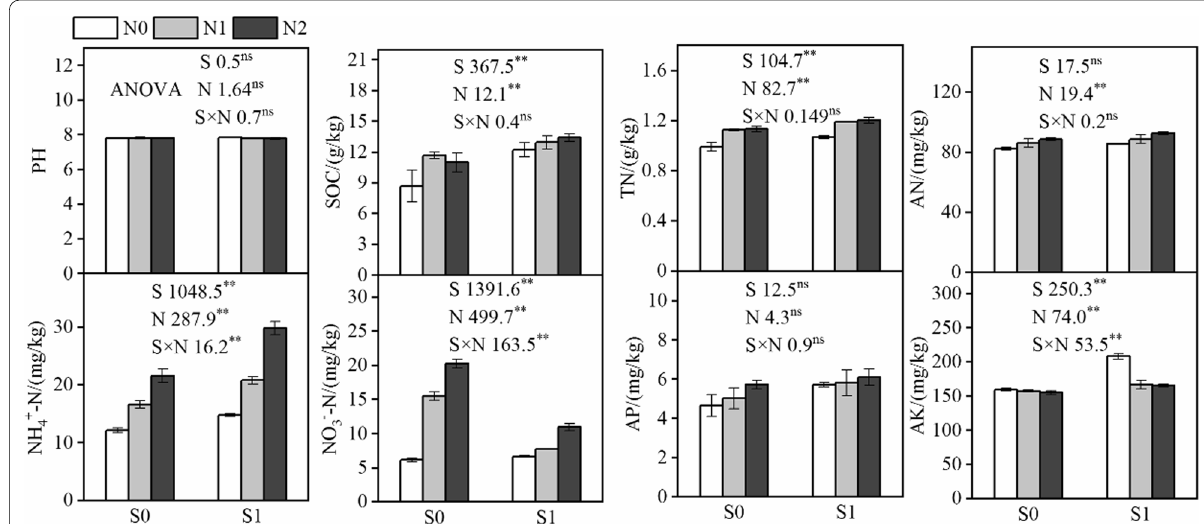
Fig. 2 Analysis of variance of pH, SOC and TN (g kg − 1 ), AN, NH 4 + -N, NO 3 − -N, AP and AK (mg kg − 1 ). SOC: Soil organic carbon; TN: Total nitrogen; AN: Available nitrogen; NO 3 − -N: Nitrite-N; NH 4 + -N: Ammonium-N; AP: Available phosphorus; AK: Available potassium. S1: straw with nitrogen, S0: no straw with nitrogen, N0: no nitrogen, N1: 120 kg N ha − 1 , N2: 180 kg N ha − 1 .M, and N represent the maize straw mulch and nitrogen levels, respectively. * , and ** indicate significance at the 5% and 1% probability level, respectively.